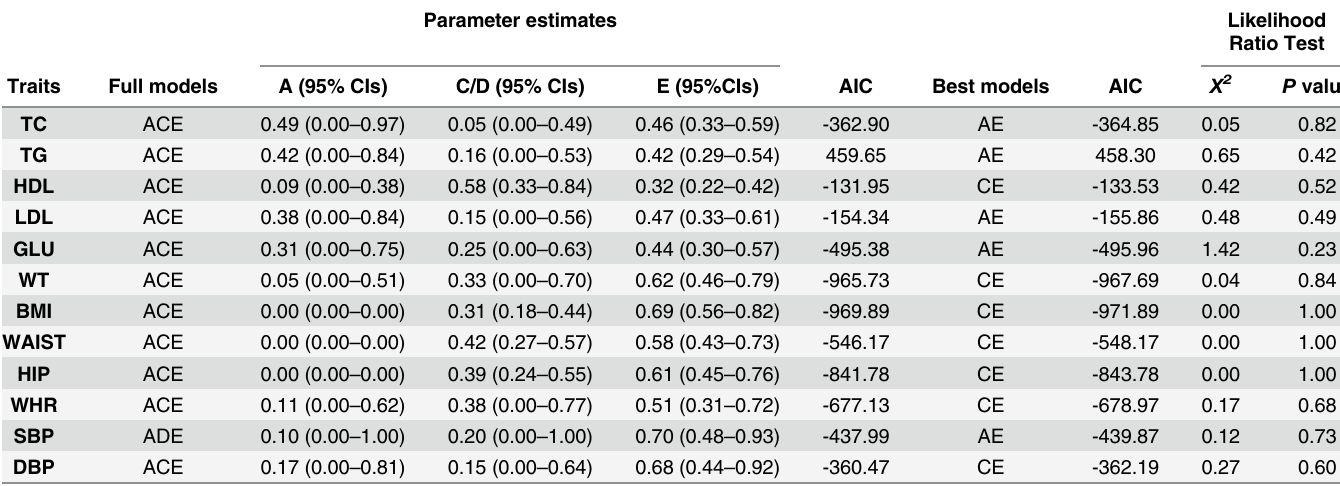
Table 4. Full models for longitudinal change of each phenotype in the Chinese twins and statistics for best fitting models. Parameter estimates